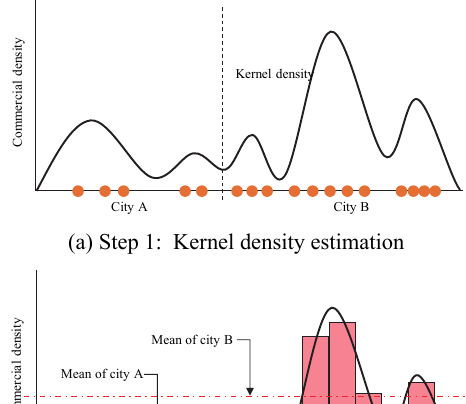
(a) Step 1: Kernel density estimation